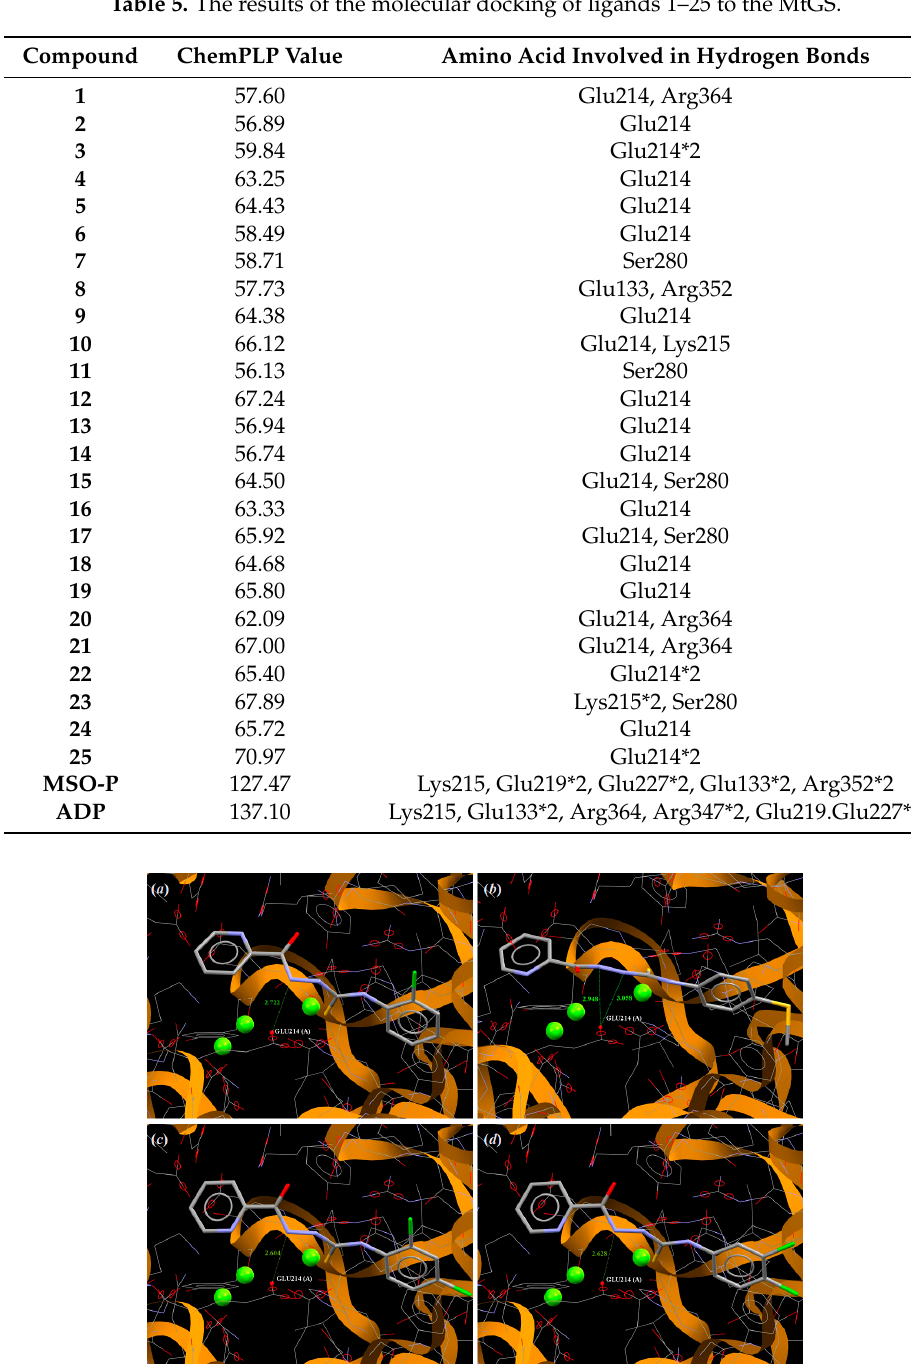
Table 5. The results of the molecular docking of ligands 1–25 to the MtGS.